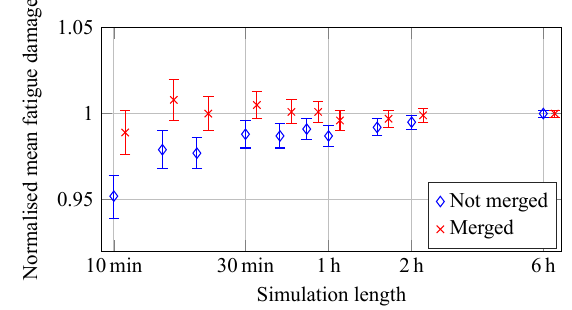
Figure 11. Normalised mean fatigue damage (500 simulations) for increasing simulation lengths and v s = 9–11ms − 1 . Environmental conditions are kept constant to demonstrate the effect of merging time series more clearly.